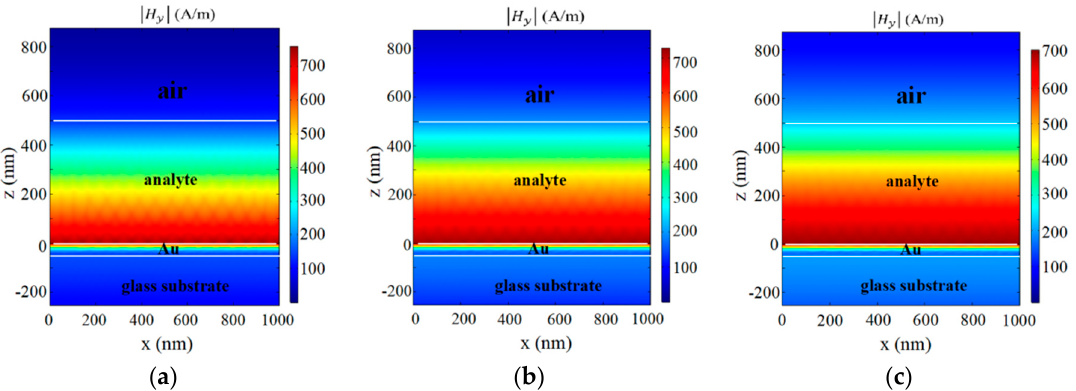
Figure 4. Simulated optical field distributions for three TM 0 resonance conditions: analyte RI of ( a ) 1.30, ( b ) 1.35, and ( c ) 1.40.